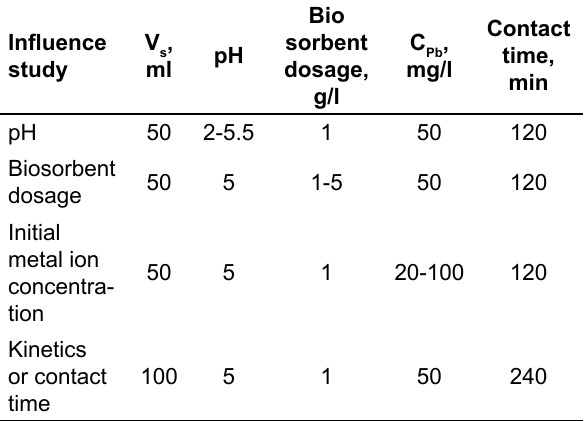
Table 1. General conditions to influence